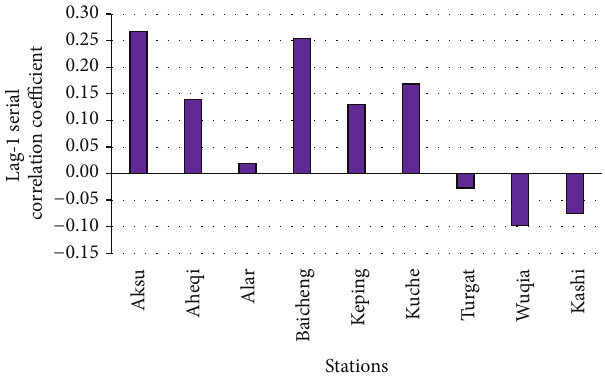
Figure 8: Lag-1 serial correlation coefficient for the SPI-12 at the 9 synoptic